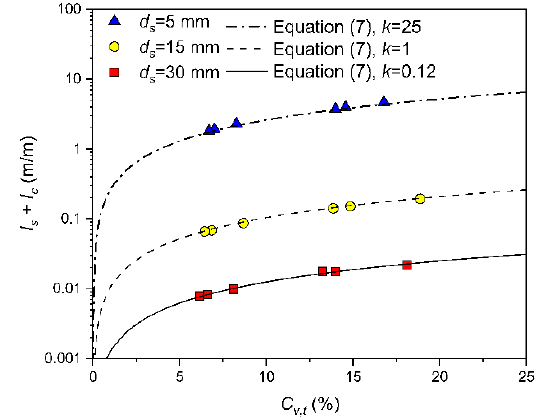
Figure 18. Relationship between I s + I c and local SVF.